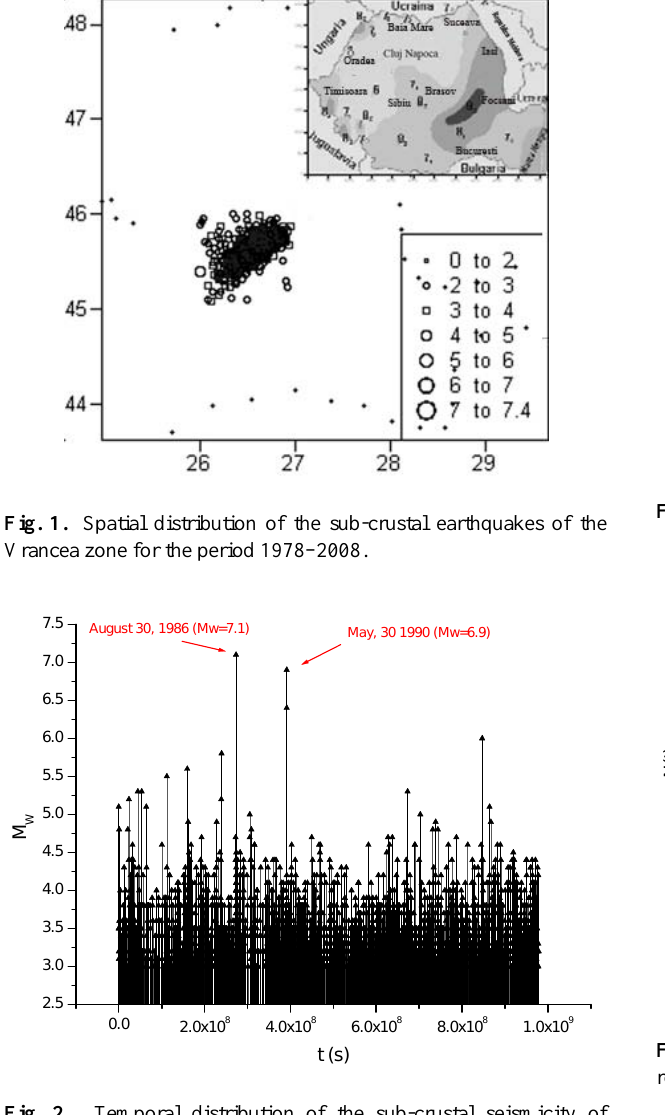
Vrancea for the period 1978–2008. The two arrows indicate the